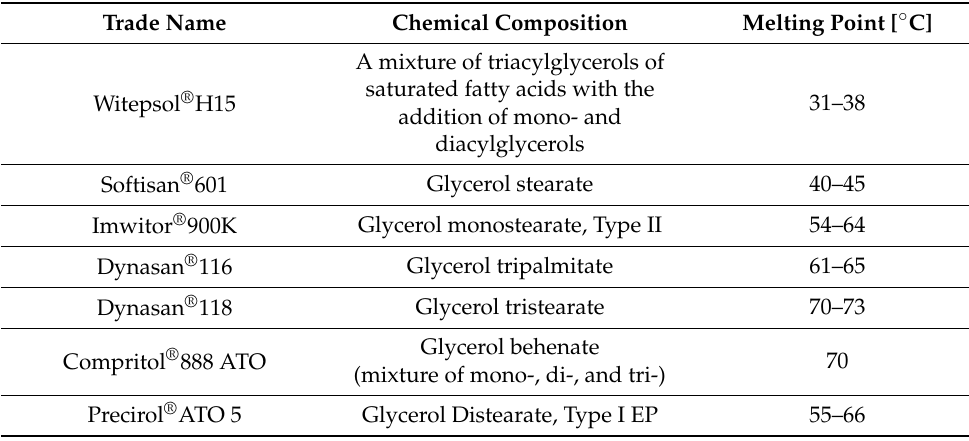
Table 2. A list of lipids with their corresponding melting